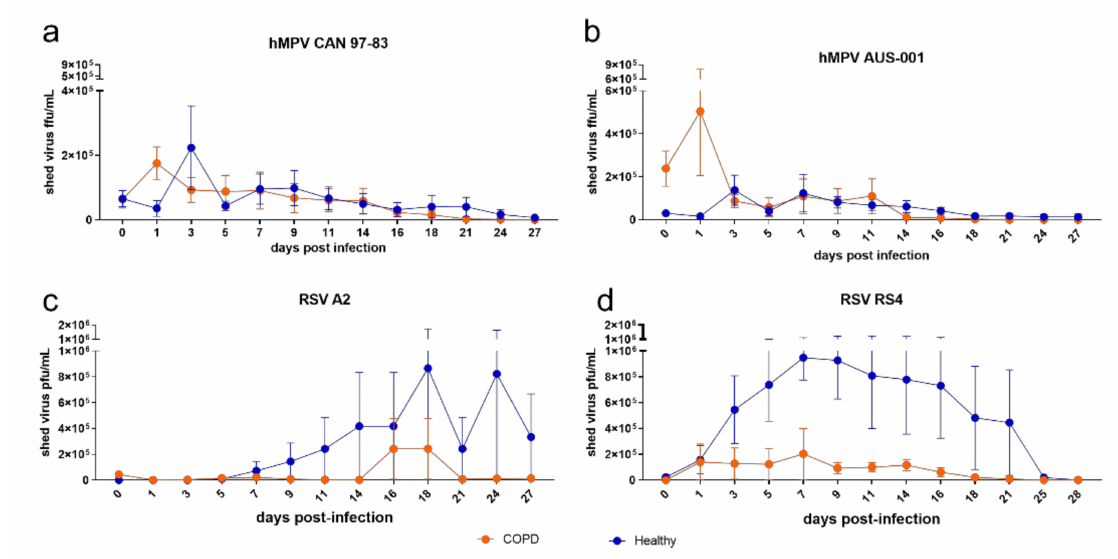
Figure 4. Virus shed by well-differentiated BEC cultures infected with ( a ) CAN 97-83 ( b ) AUS-001 ( c ) A2 or ( d ) RS4, MOI 3. The apical surface was washed every 2–3 days for 27 days and shed virus quantified by focus/plaque assay. The symbols represent the mean ± SEM. n = 5 for both COPD and healthy groups. Unpaired t -tests were performed, no statistically significant differences were